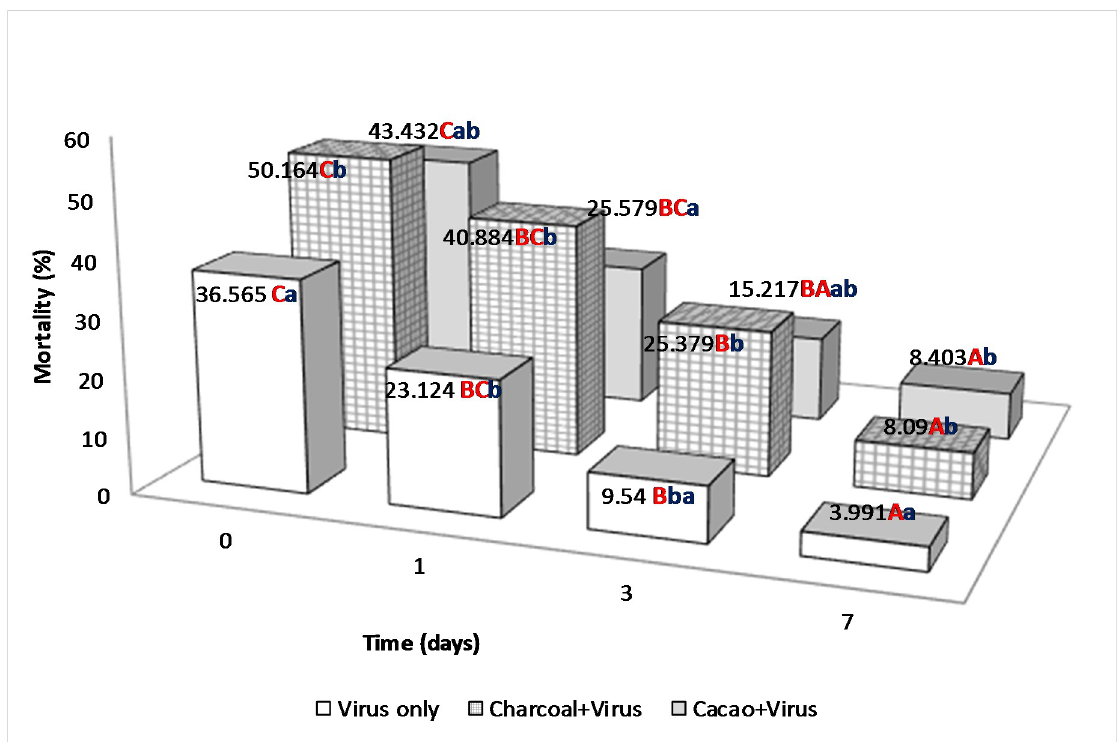
Fig 3. Percentage of mortality of 2nd instar larvae of C . chalcites at 0, 1, 3 and 7 days post application (2017). Treatments: (i) Charcoal 1% + ChchNPV-TF1, (ii) Cacao 1% + ChchNPV-TF1, (iii) Control (water + ChchNPV-TF1). � Capital letters represents differences among the treatments, lower case letters represent differences among the days post